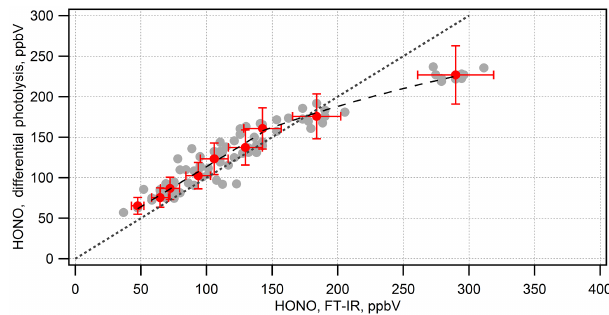
Figure 4. HONO determined by FT-IR ( y axis) versus HONO mea- sured by the photolytic/chemiluminescence differential photolysis instrument ( x axis). Median values at each dilution are in red; all values are shown in grey. The 1 : 1 line is shown for reference as well as an exponential fit above 140ppbV HONO. Error bars show the 15.8% calibration uncertainty of the pHONO instrument and the 10.0% uncertainty in the FT-IR cross section (Barney et al., 2000).